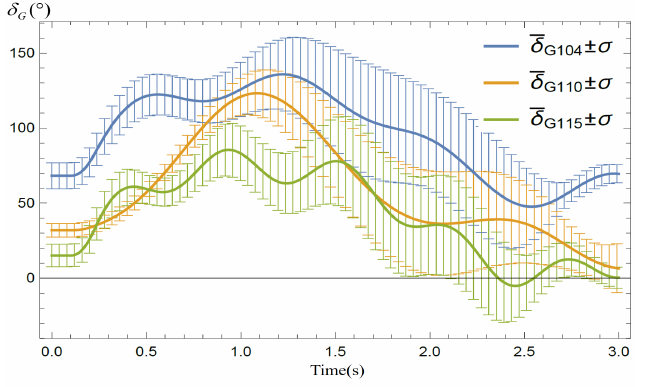
Figure 10. Expectation and standard variance of rotor angles in the base case of IEEE 145-bus system.